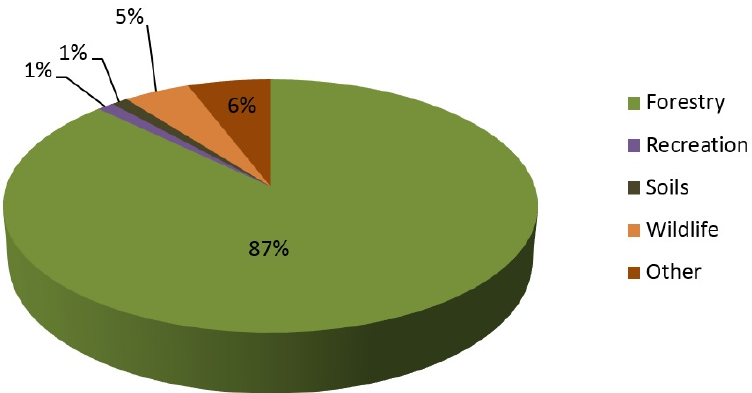
Figure 1. Primary field of work for recent graduates from forestry programs at Mississippi State University, Oregon State University, and the University of Georgia.